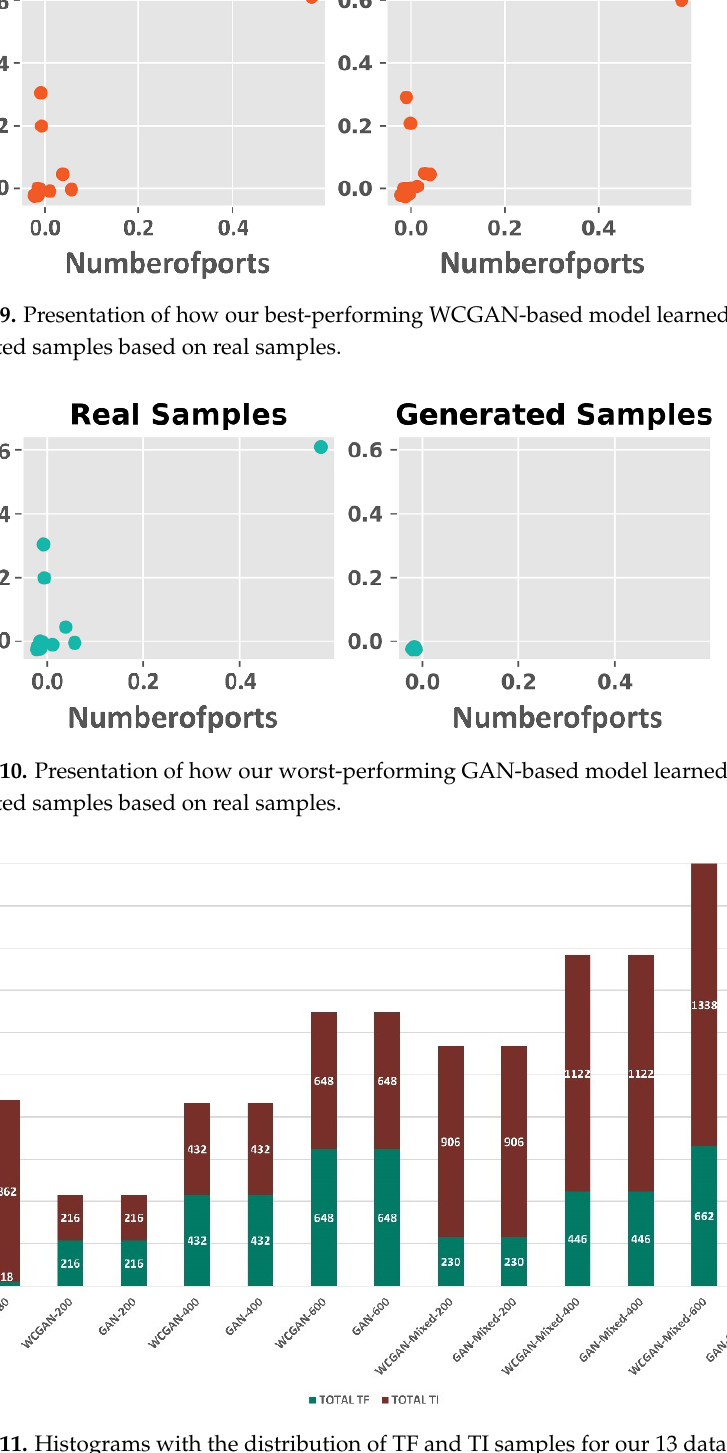
Figure 11. Histograms with the distribution of TF and TI samples for our 13 data sets.